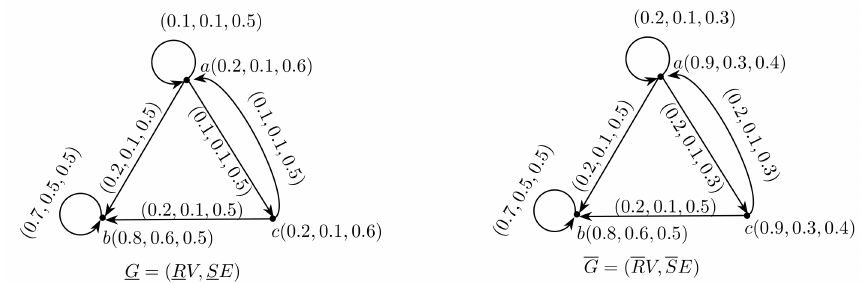
Figure 1. Rough neutrosophic digraph G = ( G , G )